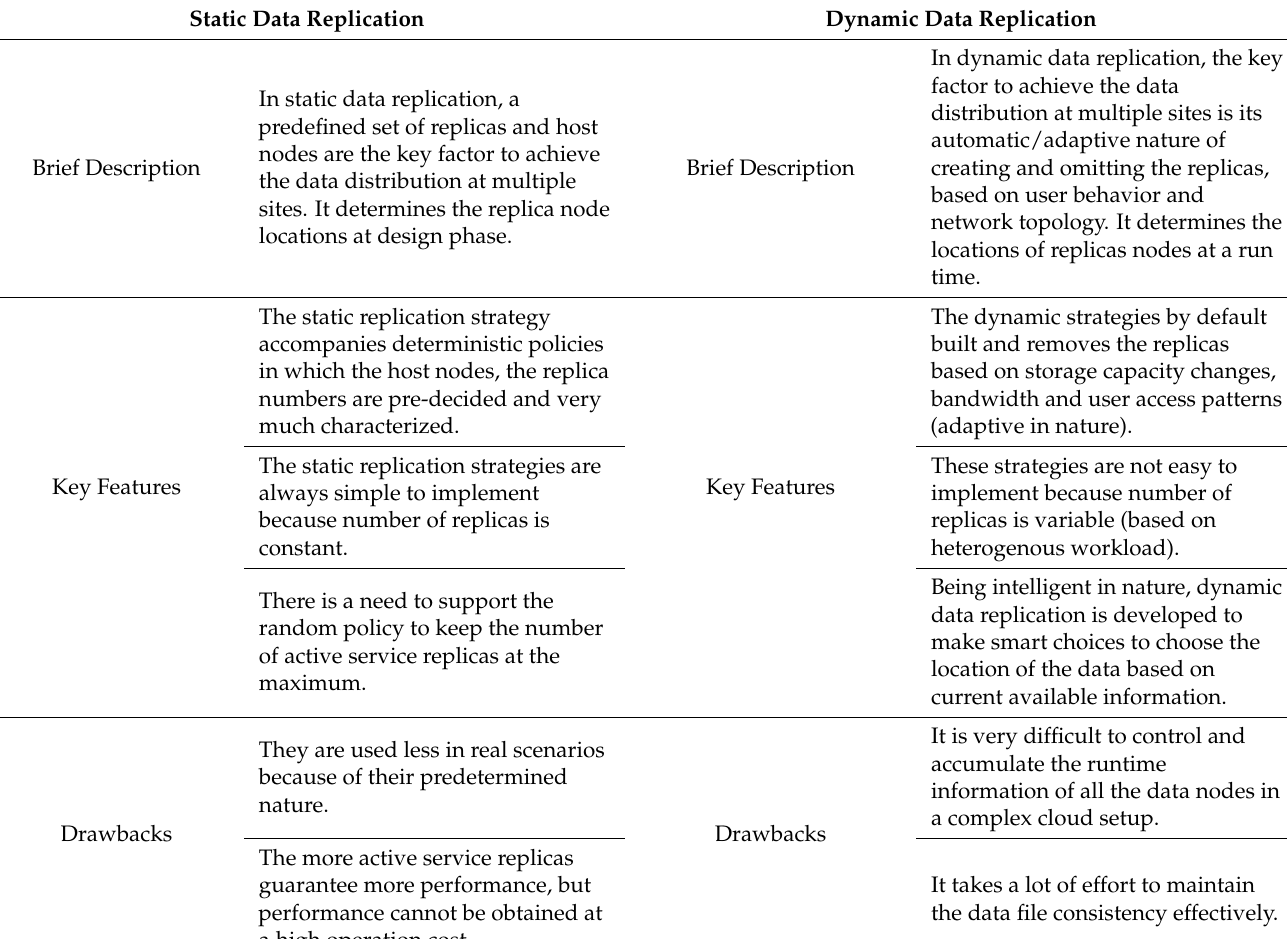
Table 2. Static data replication versus dynamic data